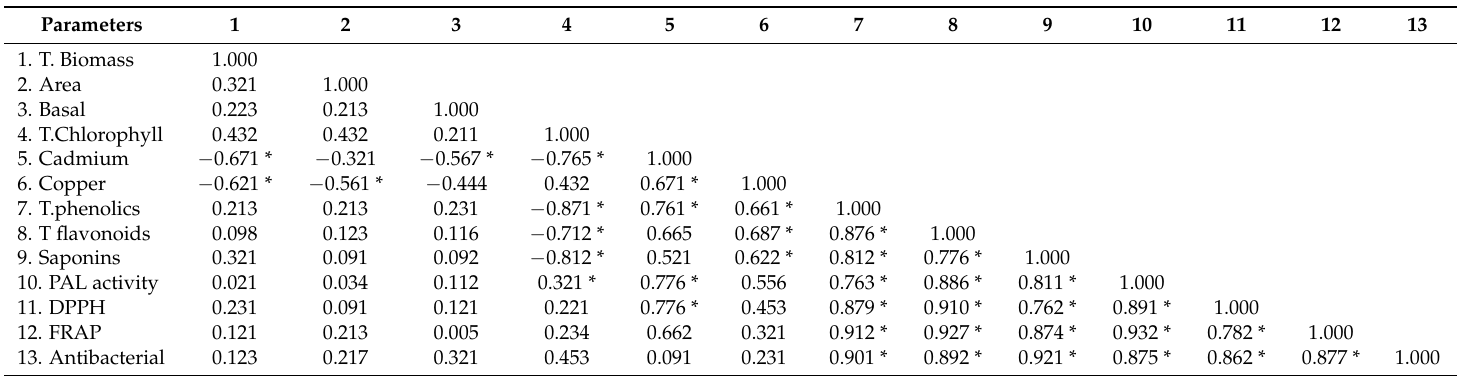
Table 2. Correlations among the measured parameters in the